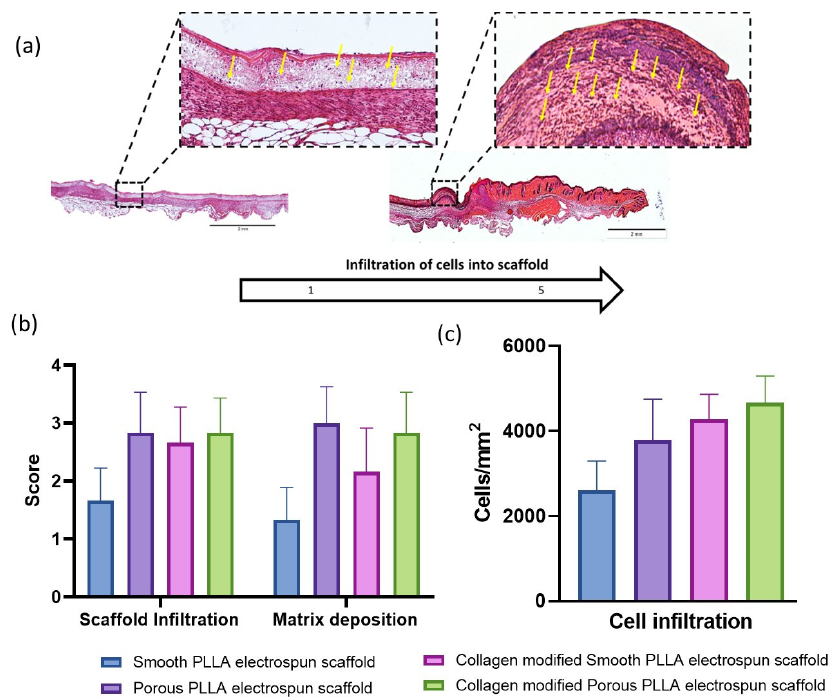
Figure 5. Infiltration of cells into and matrix deposition around the scaffold represented as a score from 0–5. ( a ) 100 X magnified images of representative scaffolds, with low to high infiltration and deposition. Scale bar = 2 mm. Yellow arrow indicating cellular infiltration. ( b ) A score of 1 was given to the scaffold with lower infiltration, as viewed by fewer nuclei or a pink-stained matrix, as opposed to more nuclei or matrices, which were given a score of 5. ( c ) Cell infiltration is represented as nuclei count (cells/mm 2 ) in scaffolds. All data are represented as mean ± SEM, n = 6 mice. Masson’s Trichome staining, wherein collagen fibers, the primary ECM component, [44] are stained in blue/green colour; this was carried out to evaluate the collagen for ‐ mation and distribution in the healing wound on day 7 and 14 (Figure 6a), where the relative intensity of blue staining corresponds to the amount of collagen deposited and indicates the progression of collagen synthesis and remodeling within the wound tissue